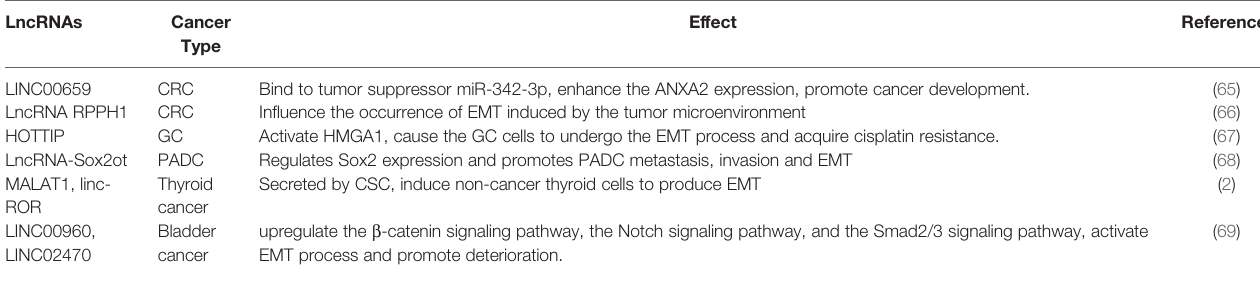
TABLE 3 | The effects of lncRNAs carried by exosomes on EMT.